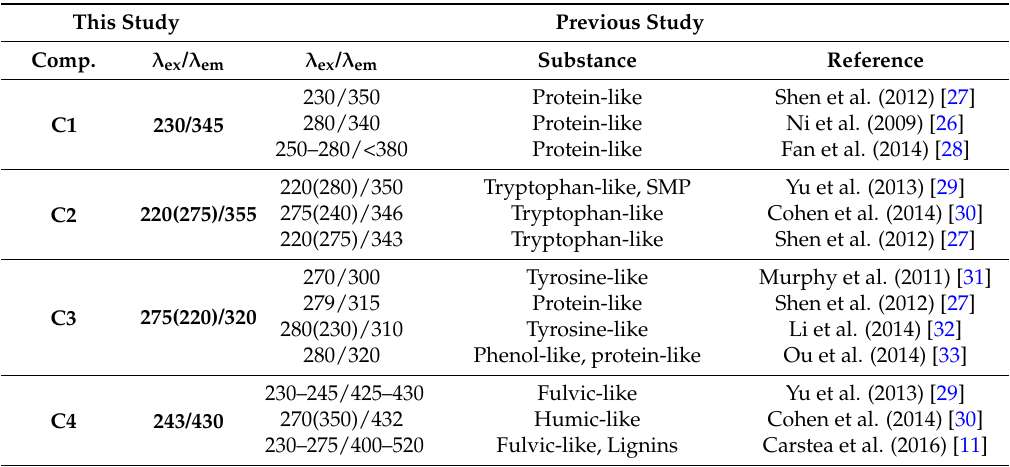
Figure 4. Typical excitation–emission matrices (EEM) for the wastewater samples. ( a ) protein-like C1 component; ( b ) tryptophan-like C2 component; ( c ) tyrosine-like C3 component; ( d ) fulvic-like C4 component. Table 2. Characteristics of the fluorescence excitation–emission matrices (FEEM) peaks in this study, and commonly observed FEEM peaks from previous studies. Values in brackets represent secondary peaks.